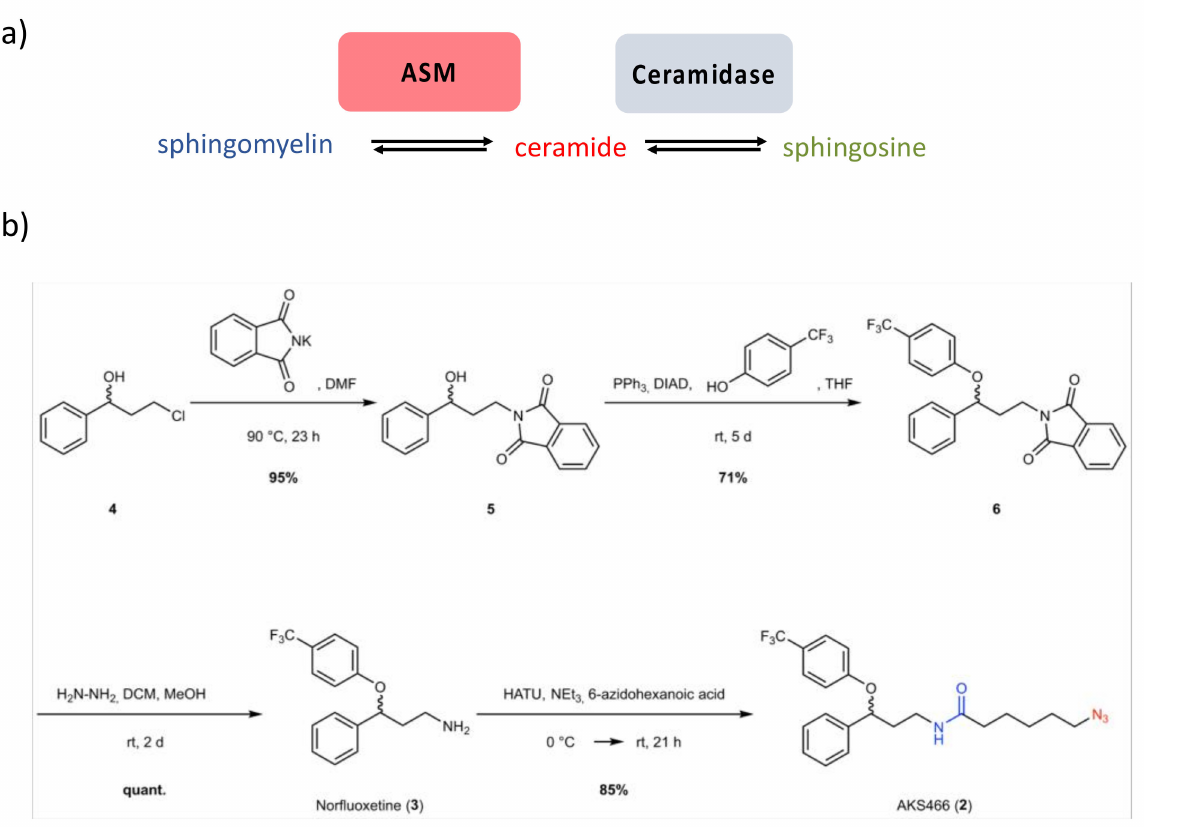
Figure 1. The sphingomyelin pathway and synthesis of compound AKS466. ( a ) Scheme sphin- gomyelin pathway, ( b ) introduction of an amide (blue) and a bio-orthogonal functional group (red) for click-reactions. The compound was synthesized as a racemate and as (R)- and (S)-enantiomers (see Supporting Materials). Abbreviations: DCM: dichloromethane, DIAD: diisopropyl azodicarboxy- late, DMF: N,N-dimethylformamide, HATU: